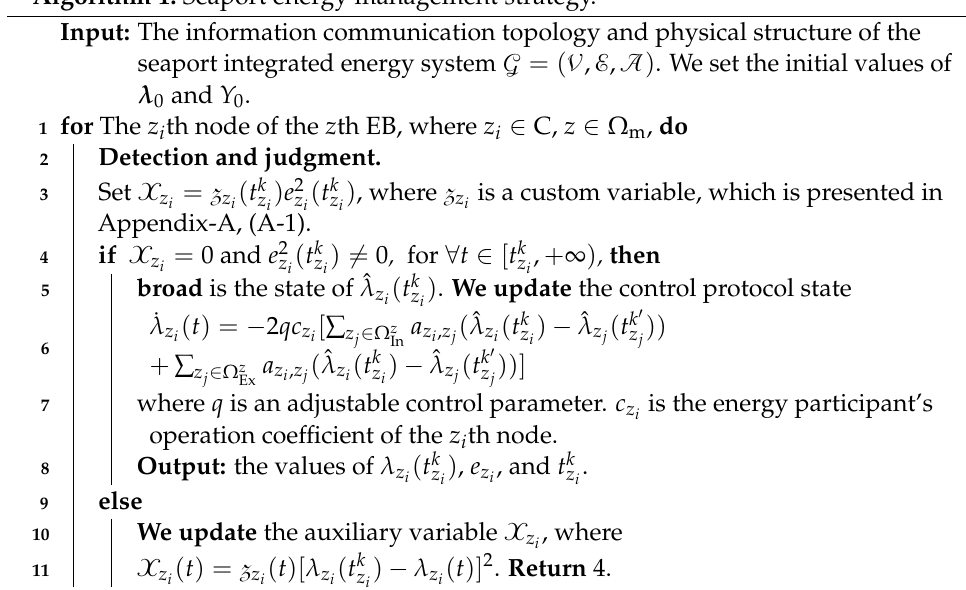
Algorithm 1: Seaport energy management